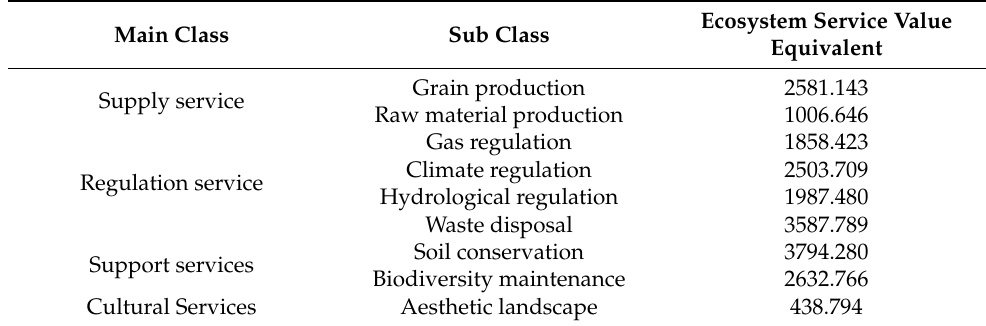
Table 1. Equivalent value of farmland ecosystem services per unit area in the two lake plains (yuan · hm 2 · a − 1 ).